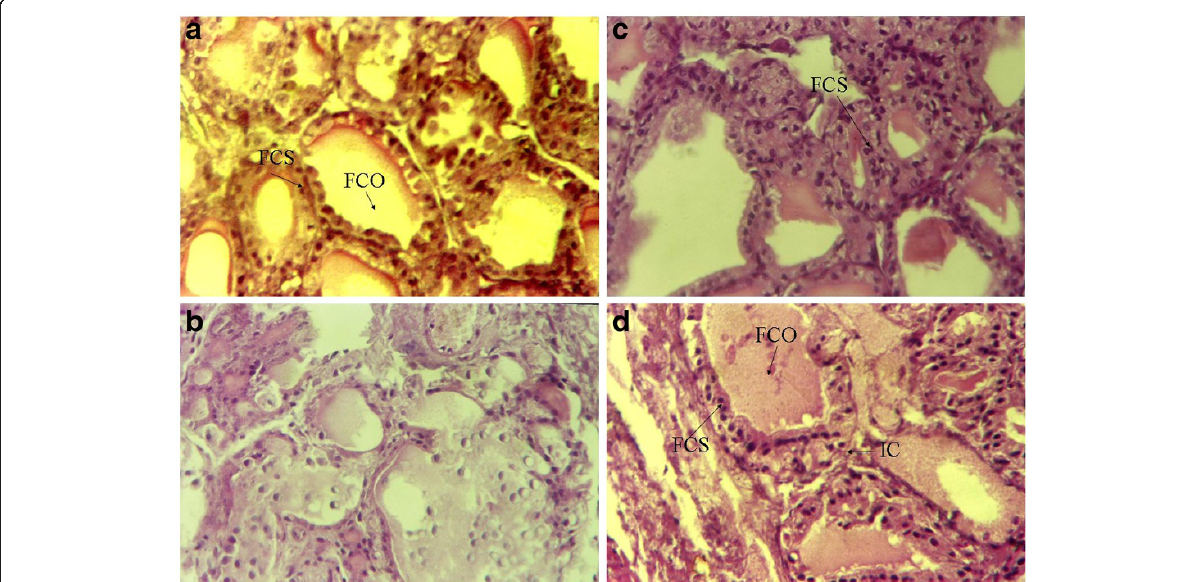
Figure 1 (1a) Hemotoxylin and Eosin-stained thyroid section of control rat (1b) CCl 4 (1c) CCl 4 + 100 mg/kg SAME (1d) CCl 4 + 200 mg/kg